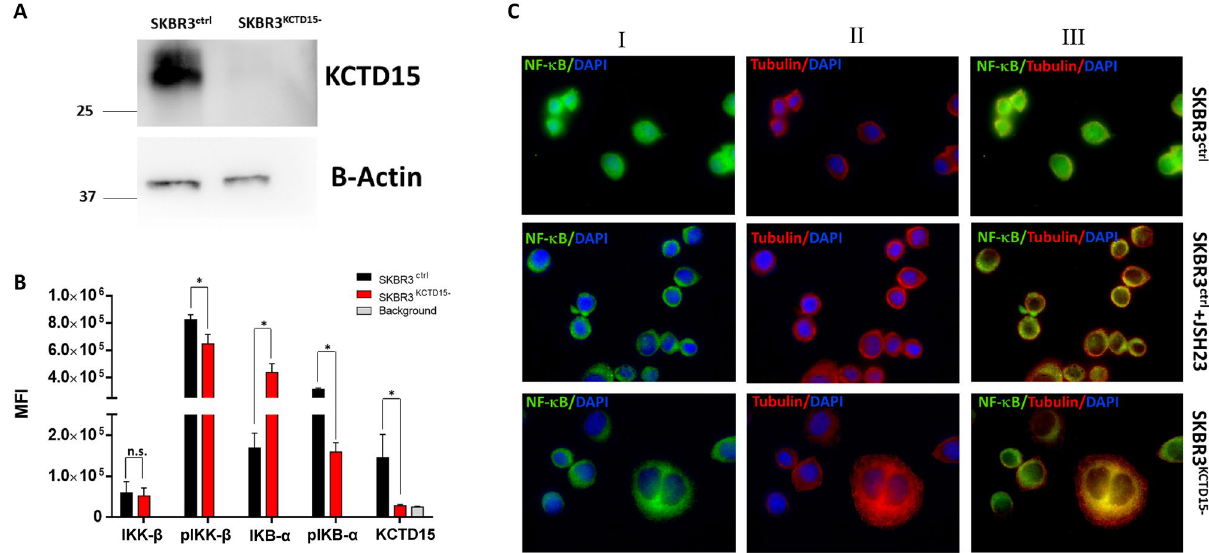
Figure 2. KCTD15 silencing in SKBR3 causes the inactivation of the NF-κB pathway. ( A) Western blot analysis of KCTD15 expression in SKBR3 ctrl and SKBR3 KCTD15− obtained by CRISP/CAS9 technology. B-Actin was used as the internal control. Numbers represent molecular weight protein markers. ( B ) Bar-plot diagram of NF-κB proteins pathway in SKBR3 ctrl (black bars) and SKBR3 KCTD15− (red bars) reported as Mean Fluorescence Intensity of two independent experiments determined by cytofluorimeter. ( C ) Immunofluorescence experiments of untreated SKBR3 ctrl (upper panels), JSH-23 treated (middle panels) and SKBR3 KCTD15− (lower panels). Fluorescence microscopy experiments. Column (I) Nuclei staining with DAPI (blue) and FITC- NF-κB RelA (green). Column (II) Nuclei staining with DAPI (blue) and PE-B-tubulin (red). (III) Overlapping of FITC, PE, and DAPI channels. Magnification × 63. Scale bars 20